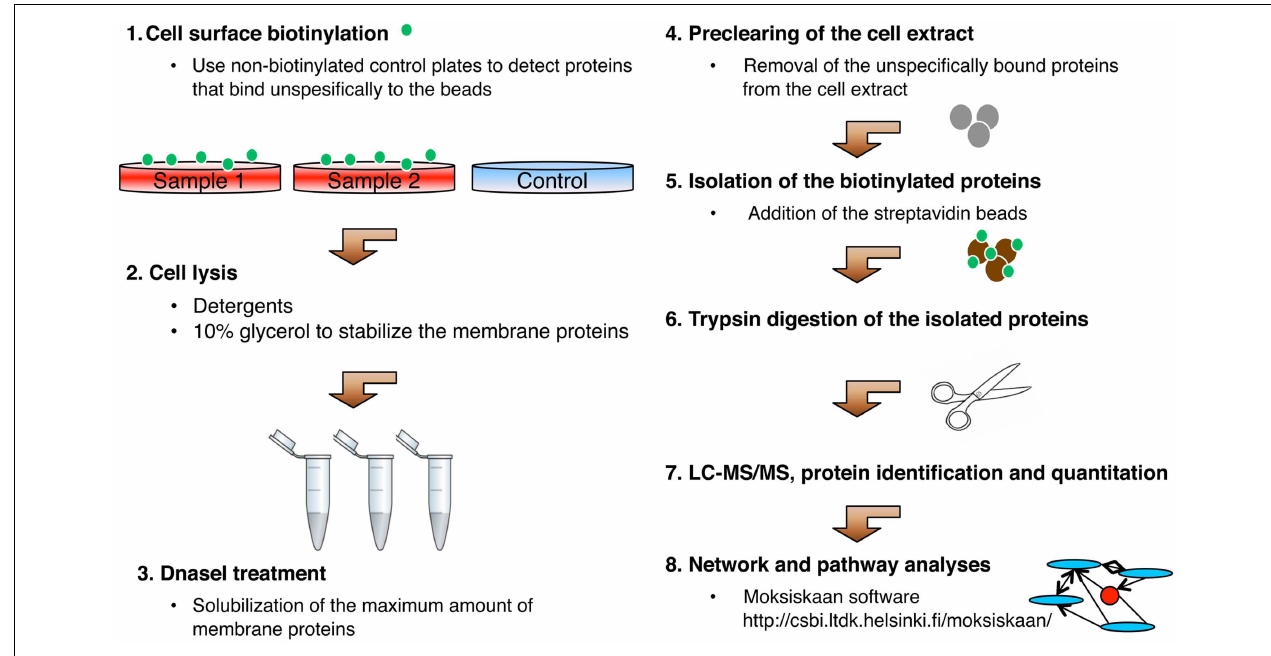
FIGURE 1 | Schematic representation of the optimized isolation of biotinylated cell surface proteins.